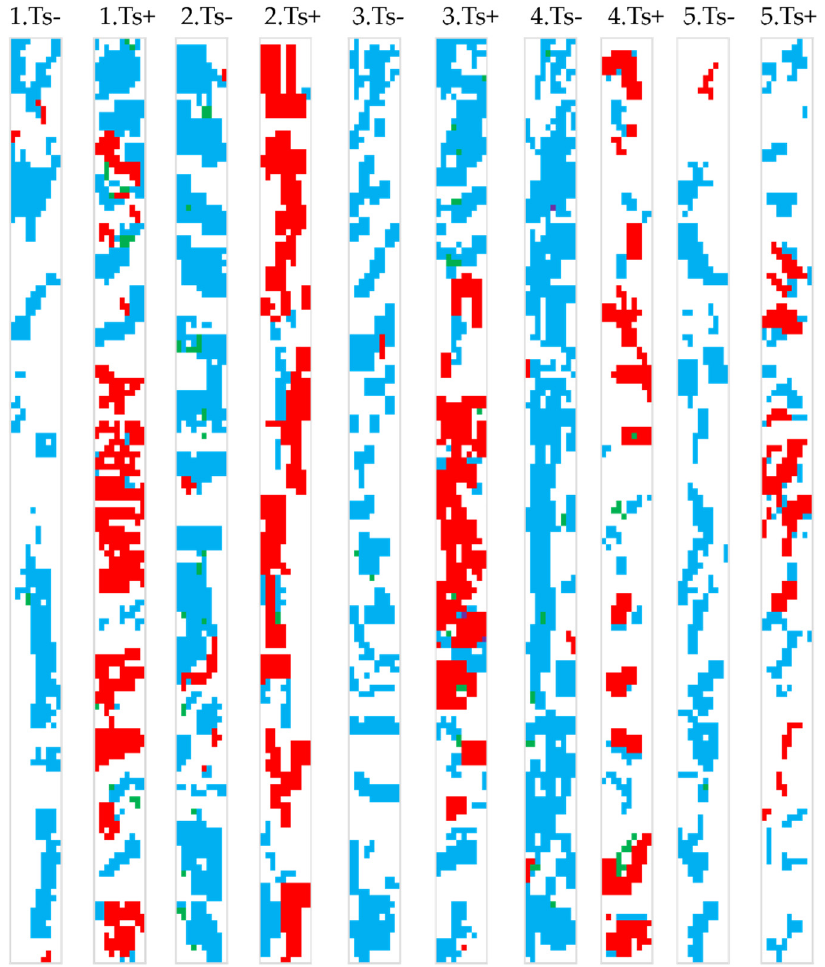
Figure 7. Transfer (Ts) colonization strategy. Legend: 1-V1 (control variant)—untreated; 2-V2—organic (manure) treatment—10 t ha − 1 manure; 3-V3—low-mineral organic treatment—10 t ha − 1 manure + 50 N 25 P 2 O 5 25 K 2 O; 4-V4—mineral treatment—100 N 50 P 2 O 5 50 K 2 O; 5-V5—high-mineral organic treatment—10 t ha − 1 manure + 100 N 50 P 2 O 5 50 K 2 O. Color Legend: blue—hyphae; red—arbuscules; green—vesicles. Minus ( − ) sign—lower model of strategy; Plus (+) sign—upper model of strategy. Square color in mycorrhizal maps: hyphae—blue, arbuscules—red, vesicles—green (based on original color code [50]).